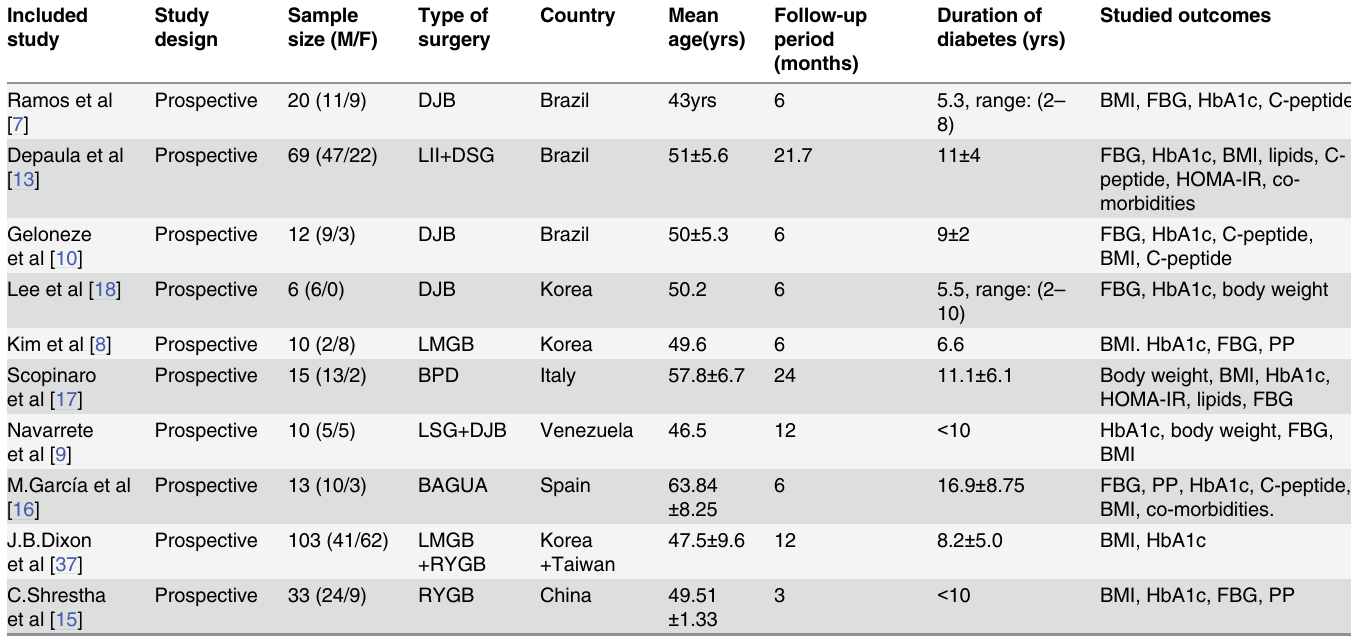
Table 1. Baseline characteristics of the included